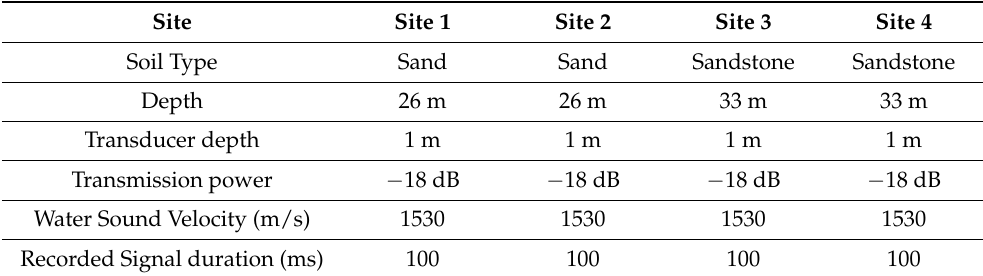
Table 1. Transmission